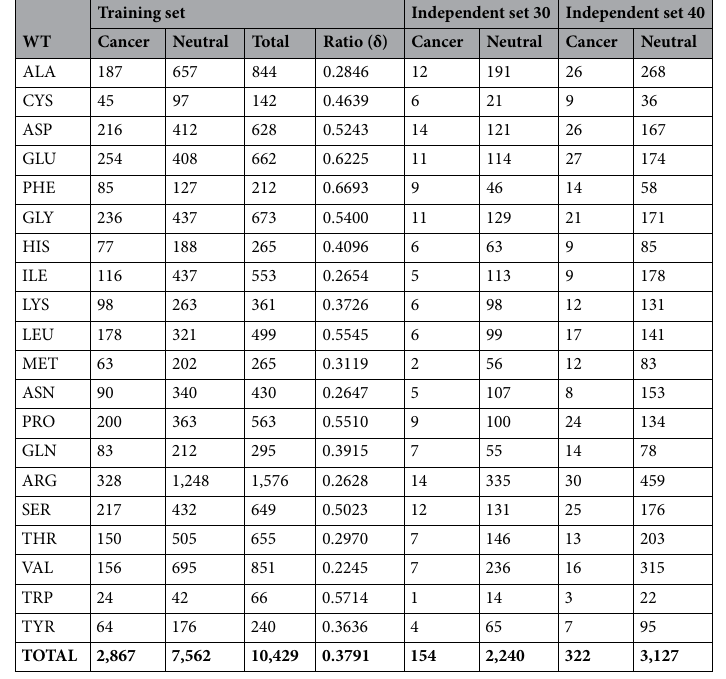
Table 1. The numbers of cancer-related and neutral SAVs for each wild-type (WT) residue and the total (bolded) in our training and independent